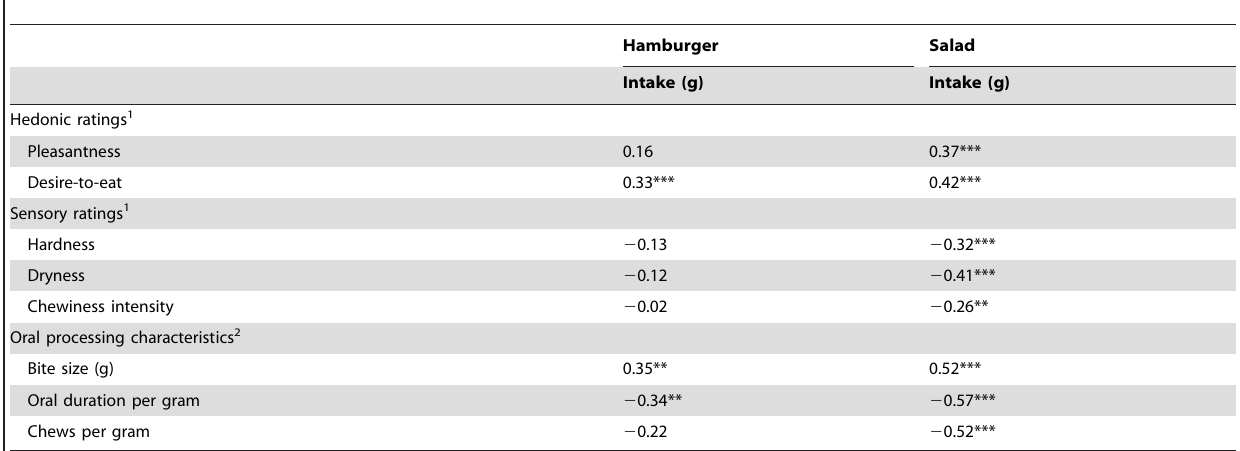
Table 4. Spearman’s correlation coefficients between food intake vs. hedonic ratings, sensory ratings, and oral processing characteristics.